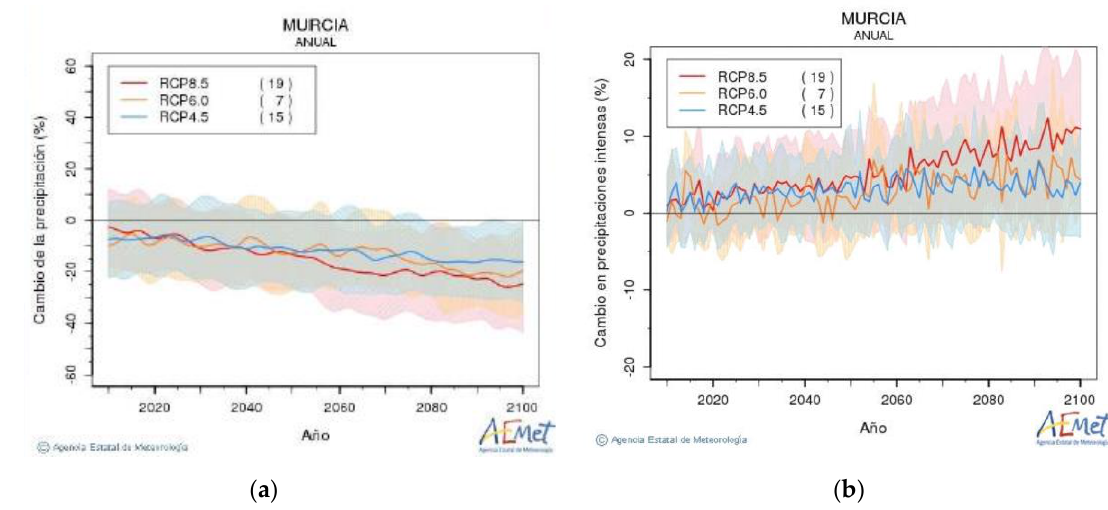
Figure 2. Climate change scenarios for 2020–2100 regarding precipitation in the Region of Murcia area using multiple regression models: annual rainfall ( a ) and maximum daily rainfall ( b ). Source: AEMET [22].